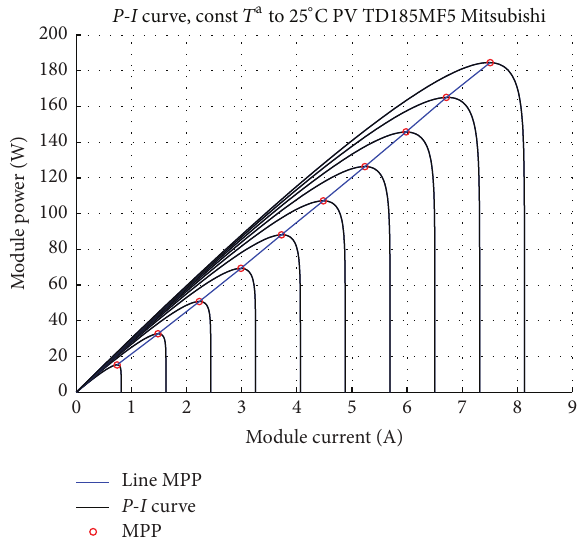
Figure 11: P - I characteristic curves of the module at different irradiance conditions.